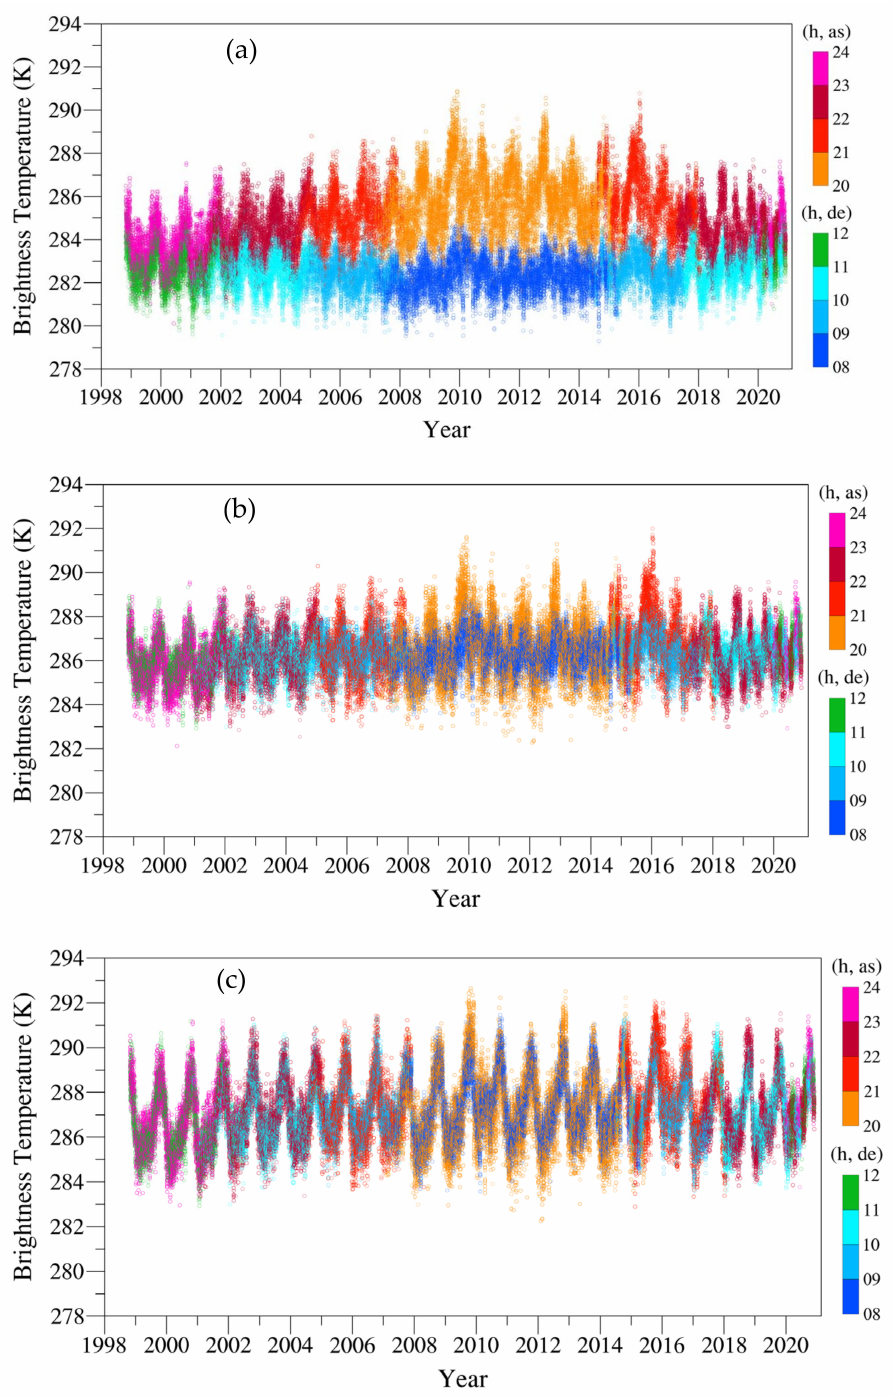
Figure 12. Time series of AMSU-A channel-3 brightness temperature observations from NOAA-15 ( a ) without any correction, ( b ) after inter-sensor bias correction, and ( c ) after inter-decadal diurnal correction. The observing local times are indicated in